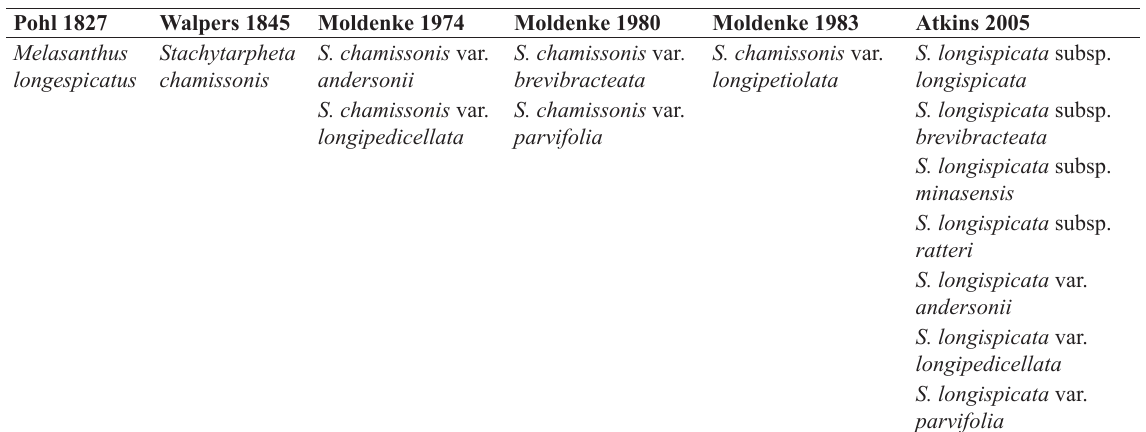
Table 1. The chronological history of the published names, and the currently accepted taxa involved in the Stachytarpheta longispicata